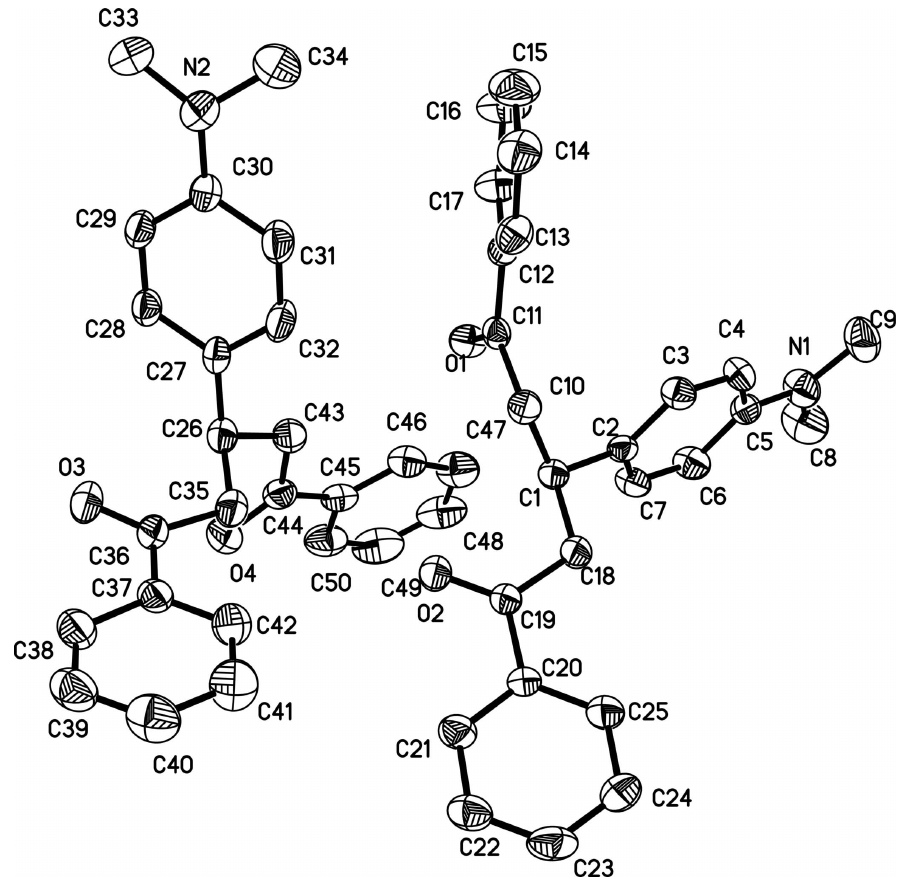
Figure 1 Two independent molecules of (I) with the atom numbering scheme and 30% probability displacement ellipsoids. Hydrogen atoms are omitted for